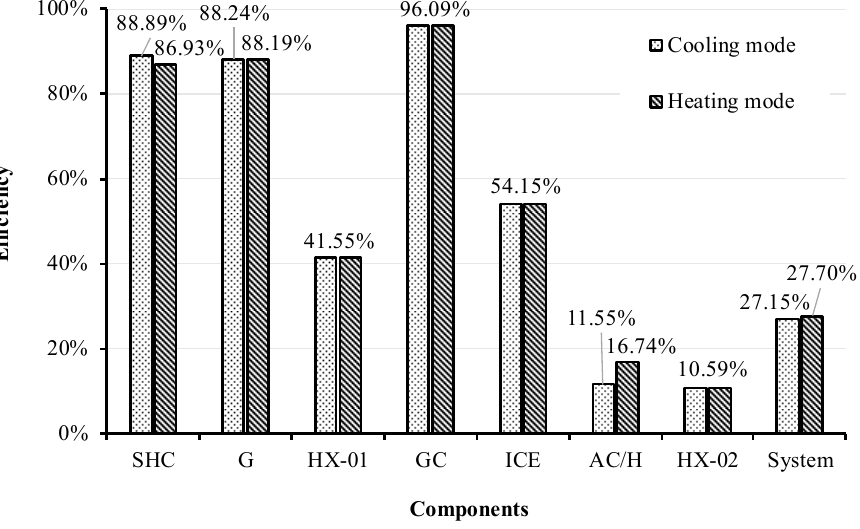
Figure 2. Exergy e ffi ciency ( η ex , sys ) of